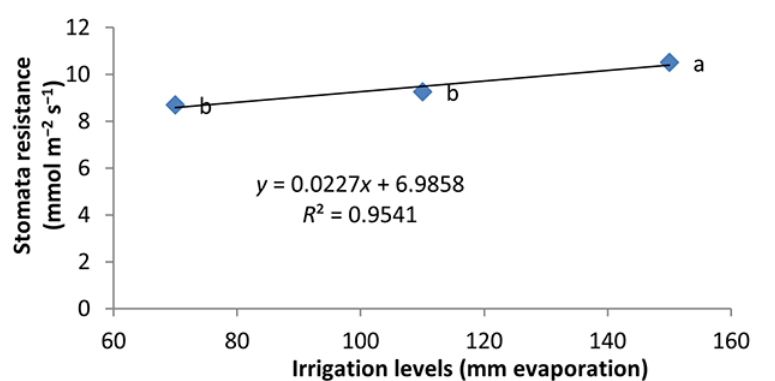
Figure 8 Effect of different irrigation levels on stomata resistance of peppermint.